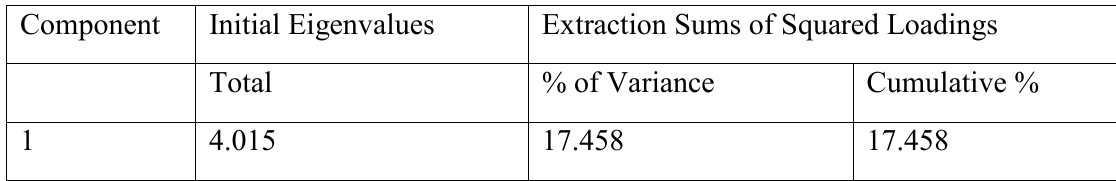
Table 1.23: Variance explained for Adaptive Resilience